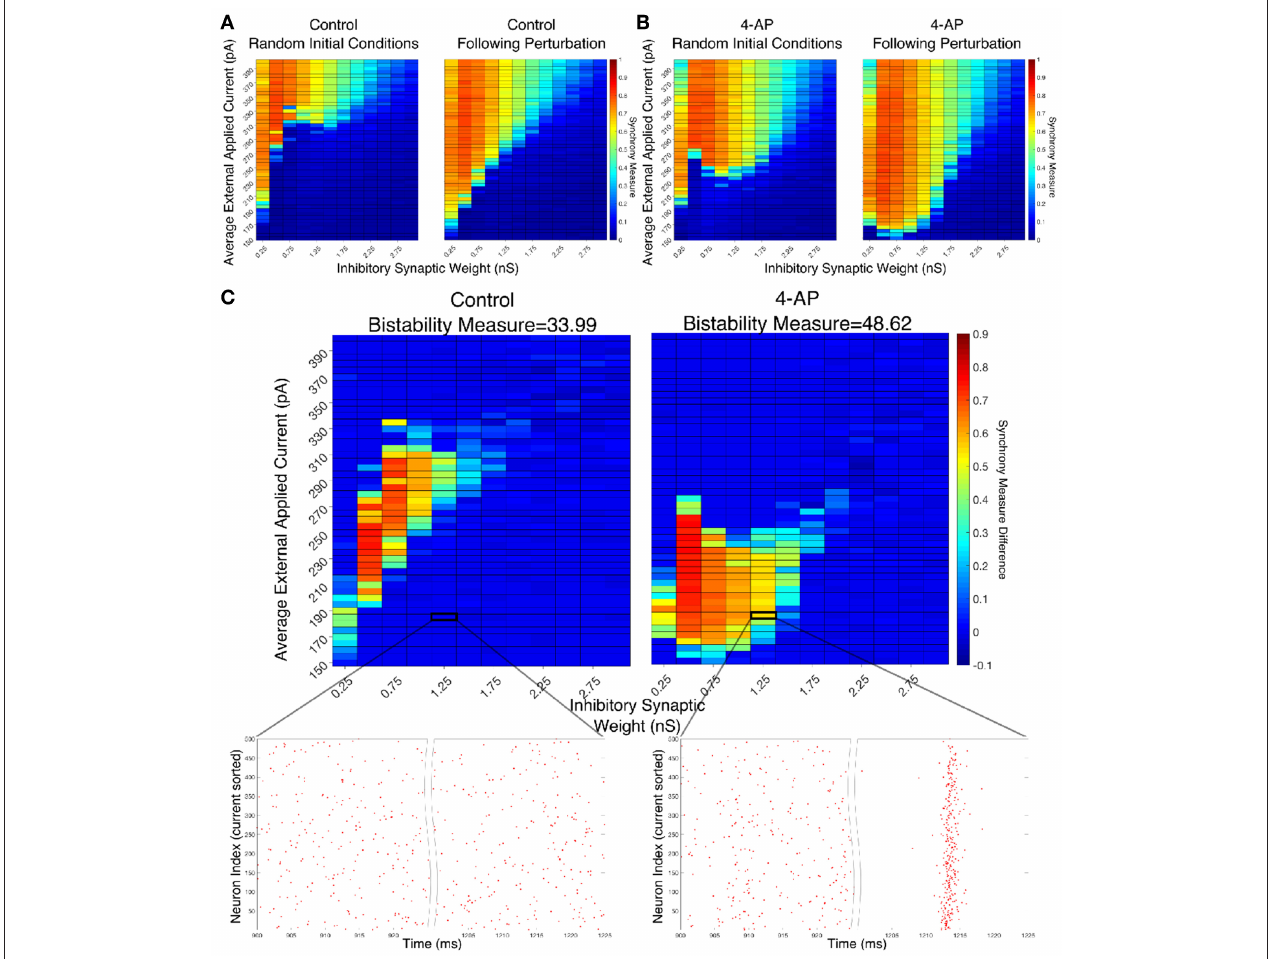
FIGURE 4 | Networks containing model 4-AP neurons are more prone to bistability than networks of control neurons. (A,B) Heatmaps displaying the Synchrony Measure for control networks (A) and 4-AP networks (B) with a connectivity probability of 0.12 and a standard deviation amongst the driving currents of 6 pA. In these heatmaps, the inhibitory synaptic weight is varied along the x-axis and the average external applied current is varied along the y-axis. The left panel displays the measure taken from randomized initial conditions, while the right panel displays the measure taken after a modeled perturbation. (C) Heatmaps over the same parameter regime, but now showing the difference between the Synchrony Measure shown in the right and left heatmaps in (A,B) . Control results are shown on the left, and 4-AP results are shown on the right. 4-AP model networks are much more likely than control model networks to exhibit a change in dynamics following the perturbation (as indicated both by more warm colors in the heatmap and by the increased Bistability Measure score shown above the panels), indicating that the perturbation induced a transition from asynchronous to synchronous dynamics indicative of a bistability. A raster plot for both the control and 4-AP settings for a network with an inhibitory synaptic weight of 1.25 nS and an average external applied current of 185 pA (corresponding to the outlined box in the heatmap) is shown, providing an illustrative example of a case where the transition from asynchronous to synchronous dynamics following the perturbation, and thus the existence of a bistability, is observed in the 4-AP but not the control